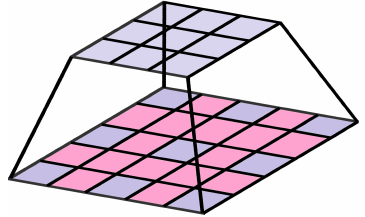
Figure 5. Dilated